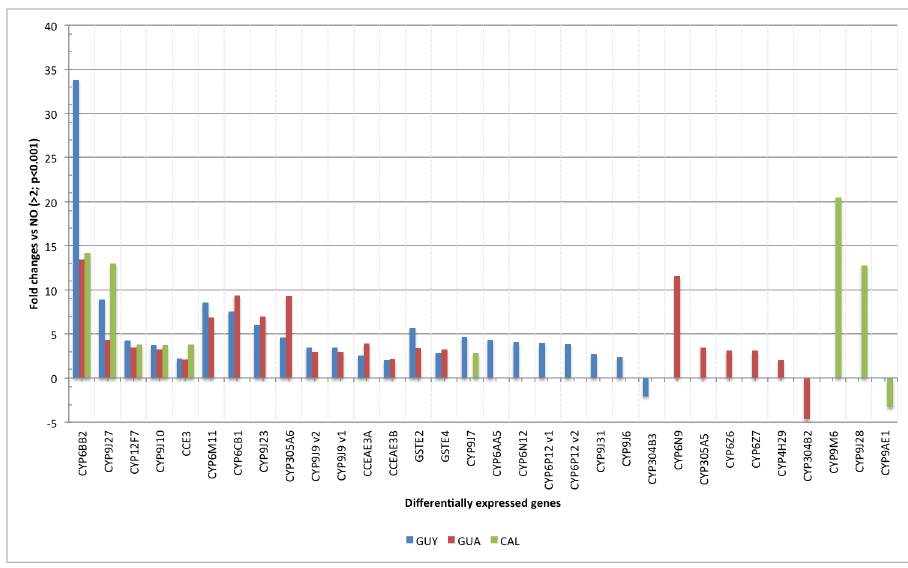
Fig 2. Fold changes of detoxification genes differentially expressed in pyrethroid resistant populations relative to the susceptible NO strain (Fold change > 2; p < 0.001). CYP: cytochrome P450 genes, CCE: carboxy/cholinesterase genes, GST: glutathione S-transferase genes.